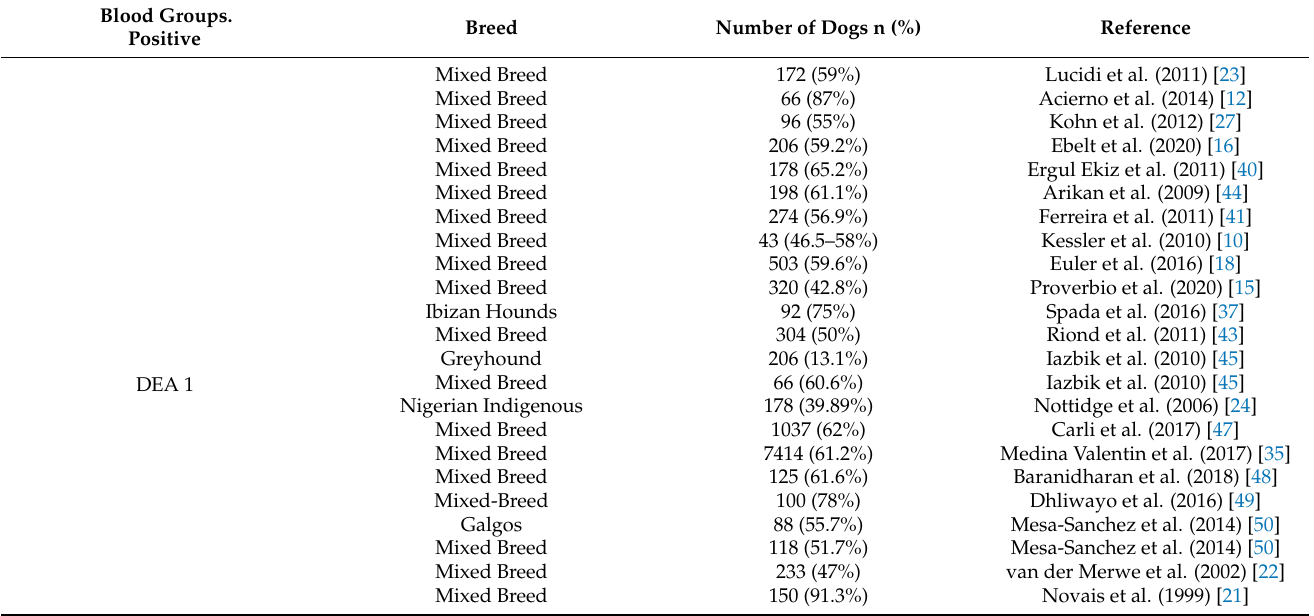
Table 2. Prevalence of blood groups (DEA 1, DEA 3, DEA 4, DEA 5, DEA 7, Dal, Kai1, and Kai2) in dogs. Blood Groups.